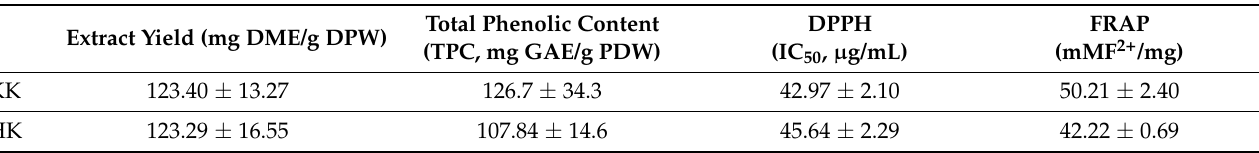
Table 1. Extract yield, total polyphenolic content (TPC) and radical scavenging activity of thyme post-distilled residue